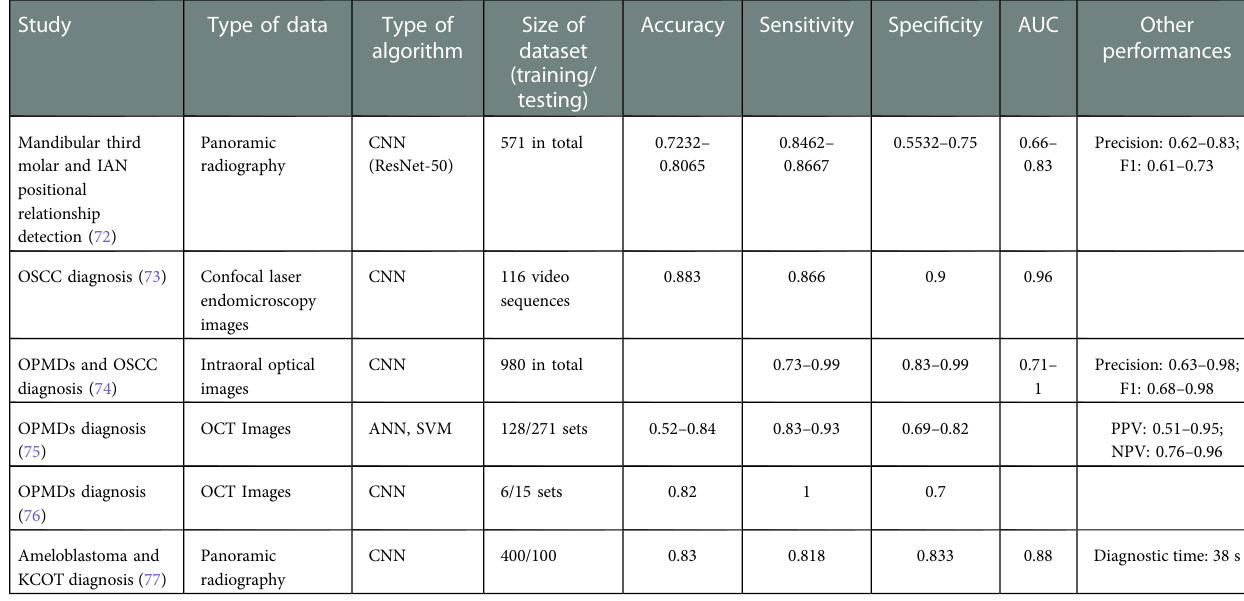
TABLE 5 Examples of AI applications in oral and maxillofacial surgery.